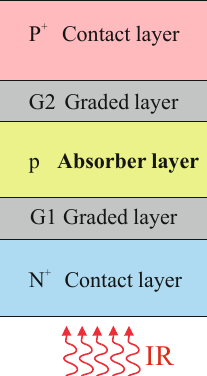
Figure 1. General scheme of the analysed detector structure.